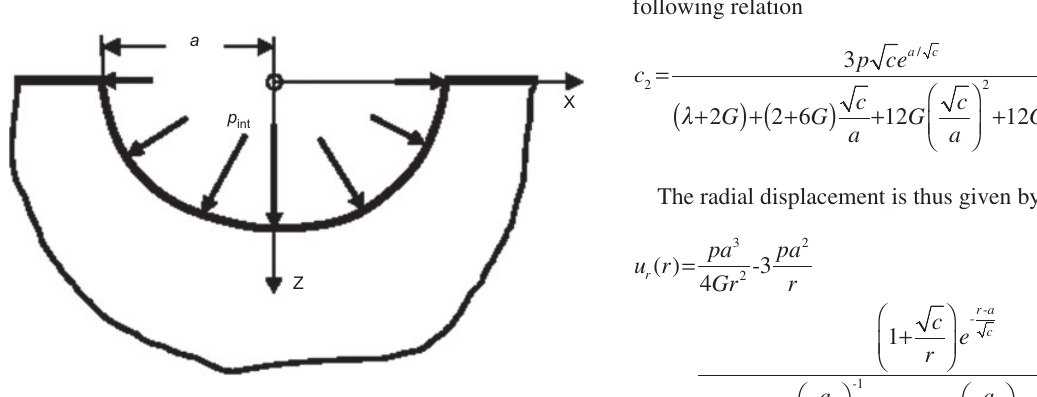
Figure 2 Schematic representation of a hemispherical core under hydrostatic pressure, formed below the tip of a penetrating